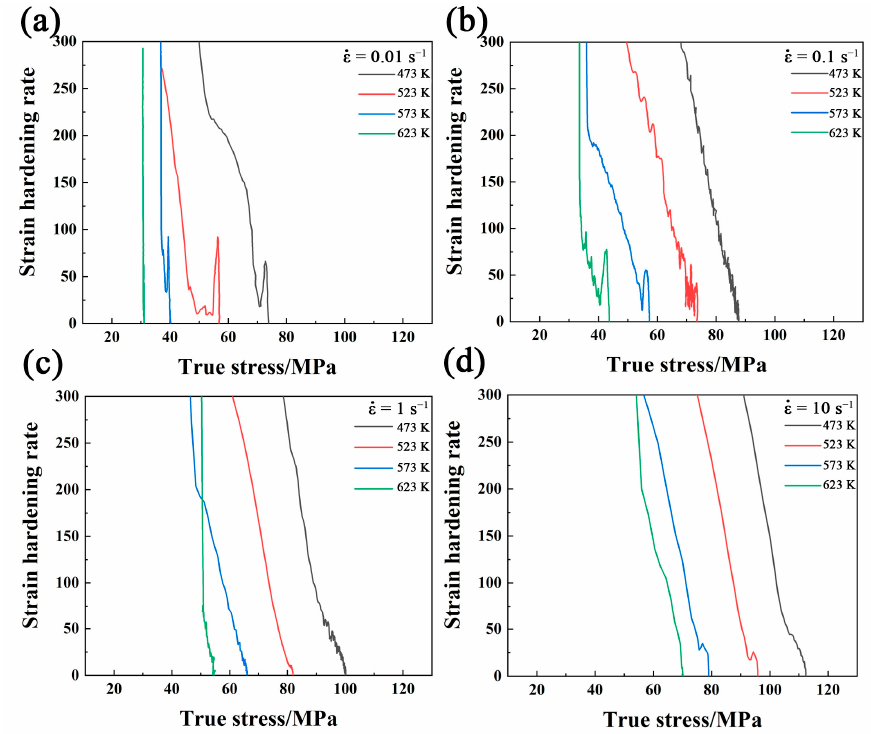
Figure 10. The plots of work hardening rate ( Θ ) against flow stress ( σ ) of Mg-3Bi alloy with different temperatures upon strain rates of ( a ) 0.01 s − 1 , ( b ) 0.1 s − 1 , ( c ) 1 s − 1 , ( d ) 10 s − 1